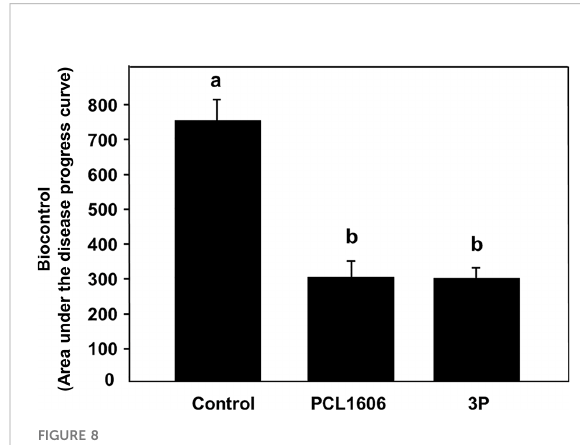
FIGURE 8 Biocontrol ability of combined 3 rhizospheric Pc strains (3P) against white root rot of avocado plants caused by Rosellinia necatrix. P. chlororaphis PCL1606 was used as a positive biocontrol reference. The area under the disease progress curve was calculated and analysed for signi fi cance after arcsine square root transformation with analysis of variance, followed by Fisher ’ s least signi fi cant difference test (P = 0.05). Average AUDPC values and standard error (error bars) of three independent experiments are presented. Values with different letters represent a statistically signi fi cant difference. 3P: Three- strain combination ( P. chlororaphis PCL1601, P. chlororaphis PCL1606 and P. chlororaphis subsp. piscium